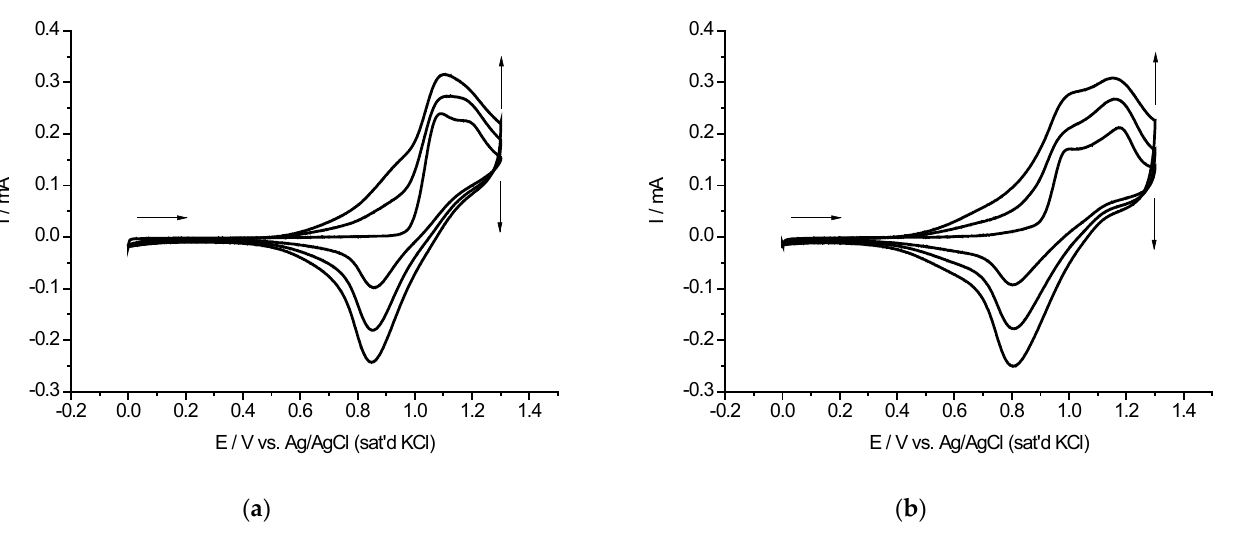
Figure 2. Cyclic voltammograms showing polymerization of [NiSalphen] ( a ) and poly[NiSalphen(CH 3 O) 2 ] ( b ) at a Pt-coated quartz crystal electrode (1.37 cm 2 ) at a scan rate of 0.05 V s − 1 in 3 · 10 − 4 monomer/0.1 M Et 4 NBF 4 /CH 3 CN. C.